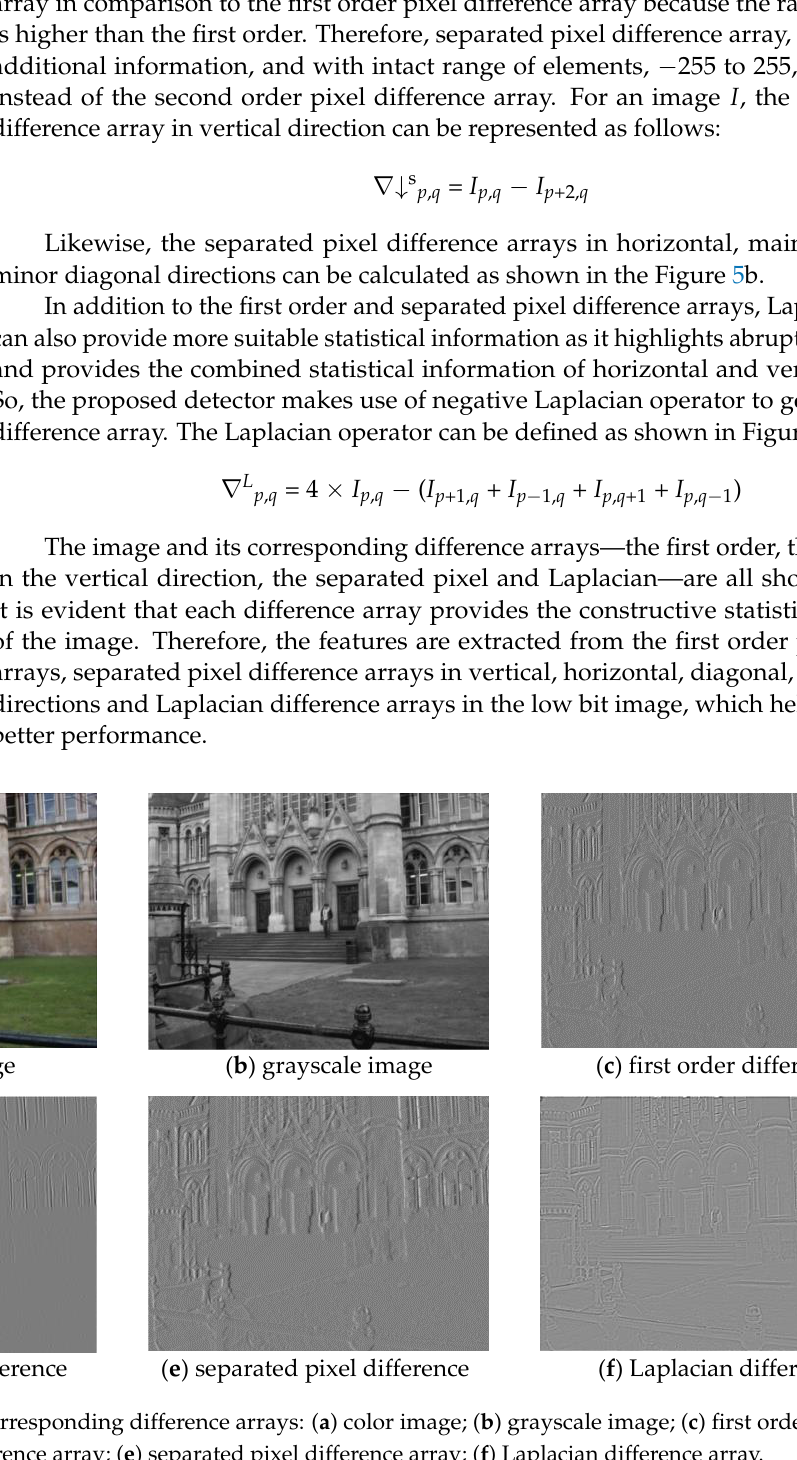
Figure 6. Image and their corresponding difference arrays: ( a ) color image; ( b ) grayscale image; ( c ) first order difference array; ( d ) second order difference array; ( e ) separated pixel difference array; ( f ) Laplacian difference array.